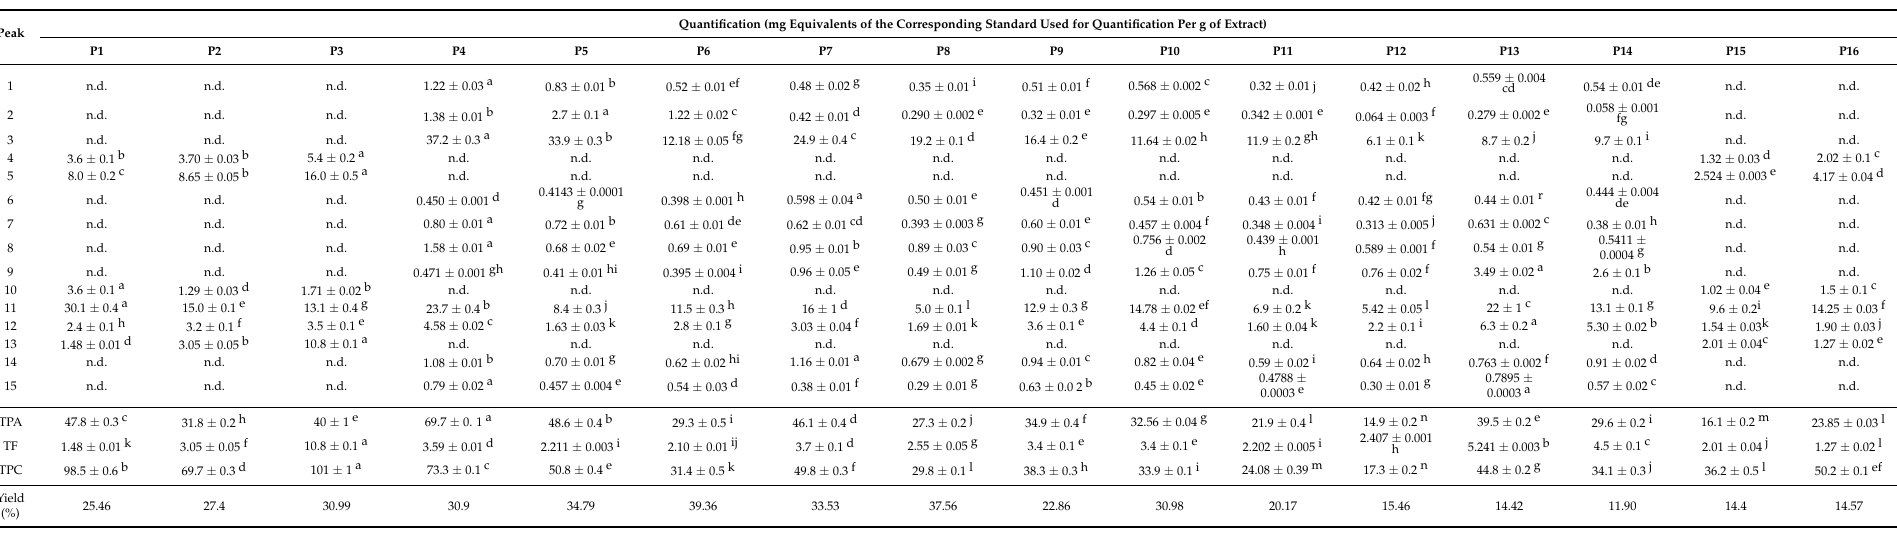
Table 2. Content of the phenolic compounds determined in the hydroethanolic extracts of cardoon